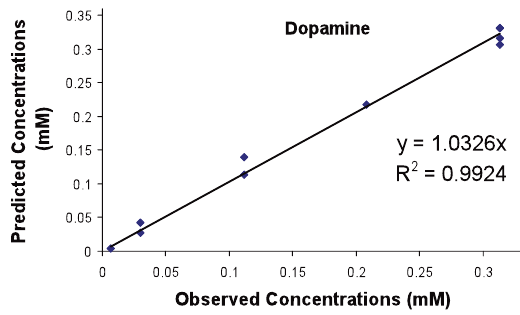
Figure 8. Predicted vs. known concentration of DA using PLS-1 model with 5 components (intercept set equal to